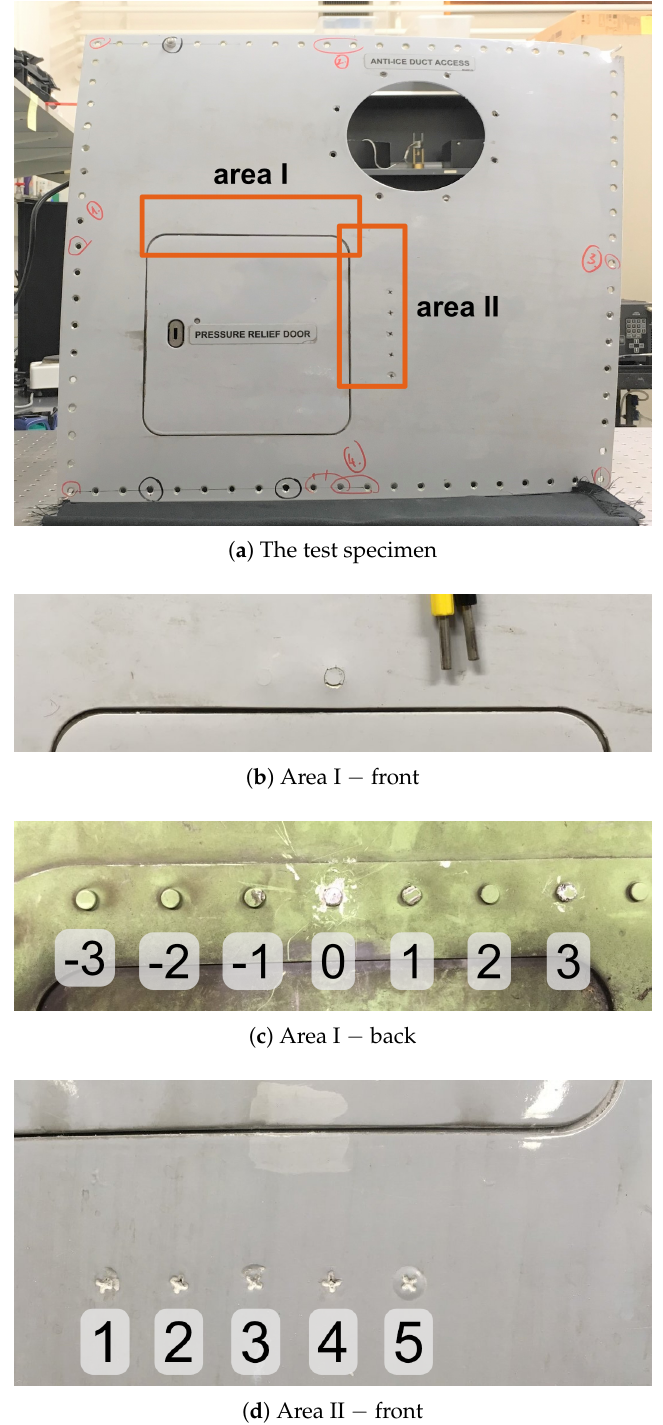
Figure 3. The two areas of a fuselage panel from an AIRBUS A320 aircraft with modified rivets which are inspected in this